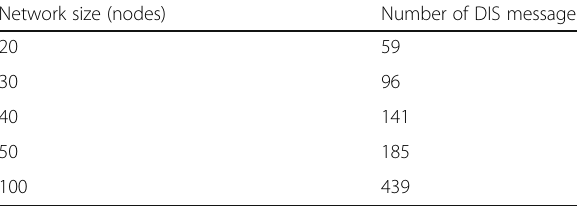
Table 6 Illustrating number of DIS messages for scenario I Network size (nodes)